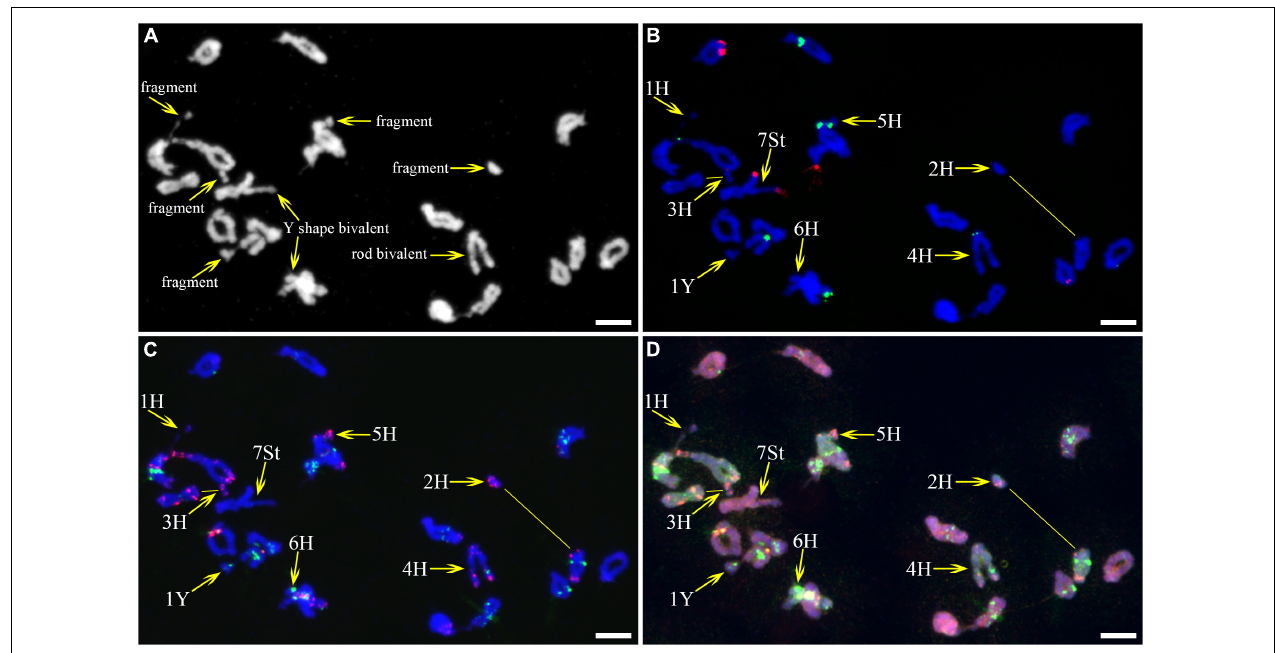
FIGURE 2 | Fluorescence in situ hybridization (FISH) patterns at meiotic diakinesis I of plant A02-1. (A) Chromosomes stained with 4’,6-diamidino-2-phenylindole (DAPI); (B) pTa71-2 (red) and pSc119.2 (green); (C) pAs1 (red) and (AAG) 10 (green); (D) genomic DNA probes of P. stipifolia (red) and H. bogdanii (green). Yellow arrows: Abnormal paired homologous chromosomes; Yellow lines: link chromosome fragments to their locations. Bars = 10 µ